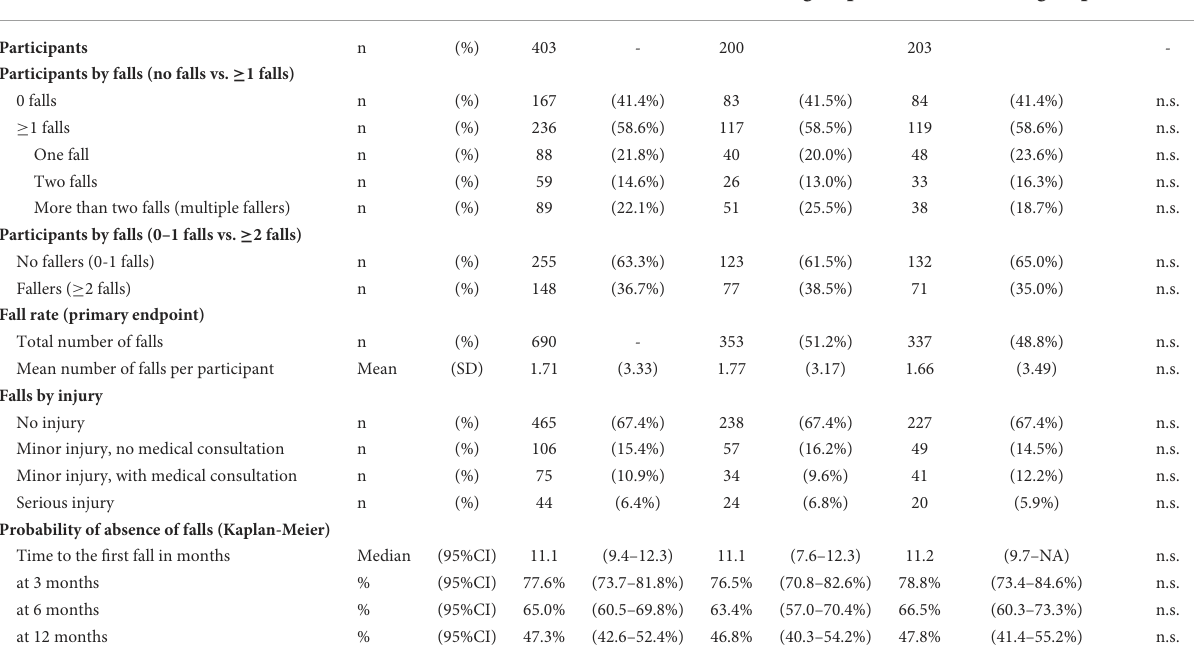
TABLE 3 Endpoint evaluation between groups (IG and